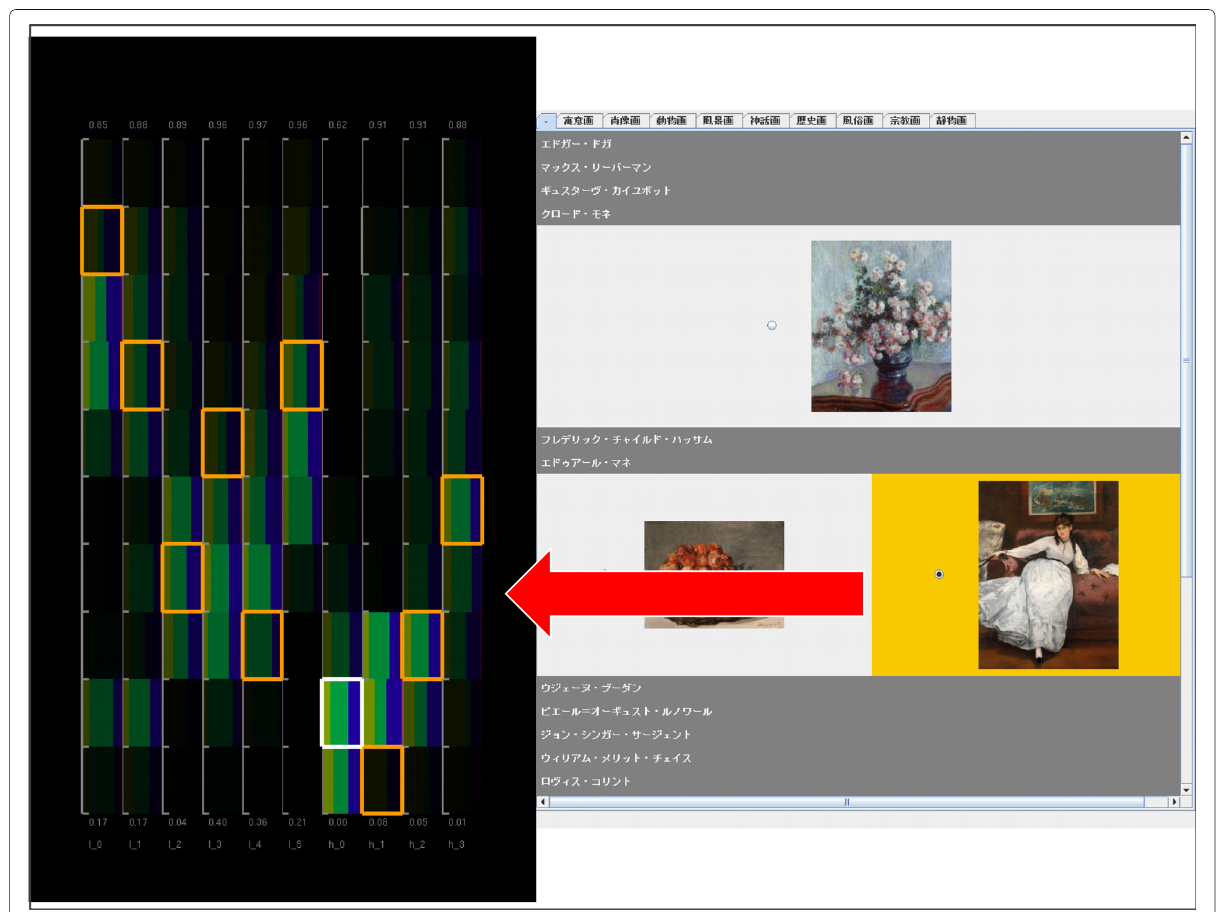
Fig. 5 Subranges corresponding to the user-selected painting image are highlighted by orange borderlines